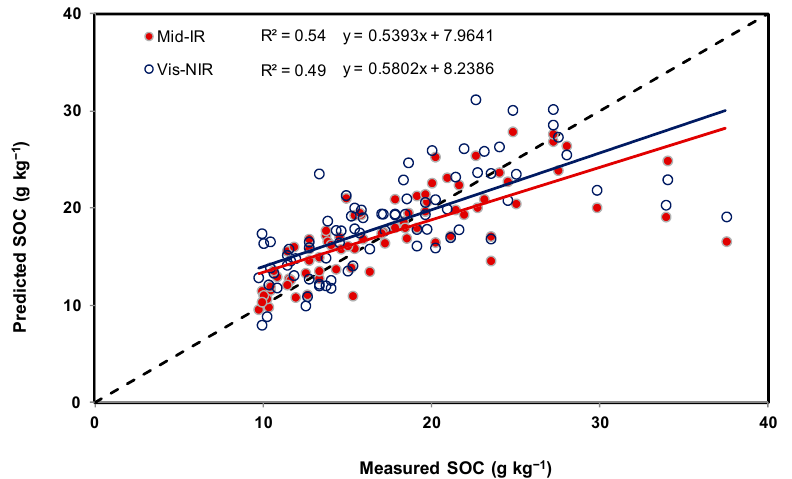
Figure 10. Relationships between measured and predicted clay, with dots representing validation examples in accordance with Tables 3 and 4.